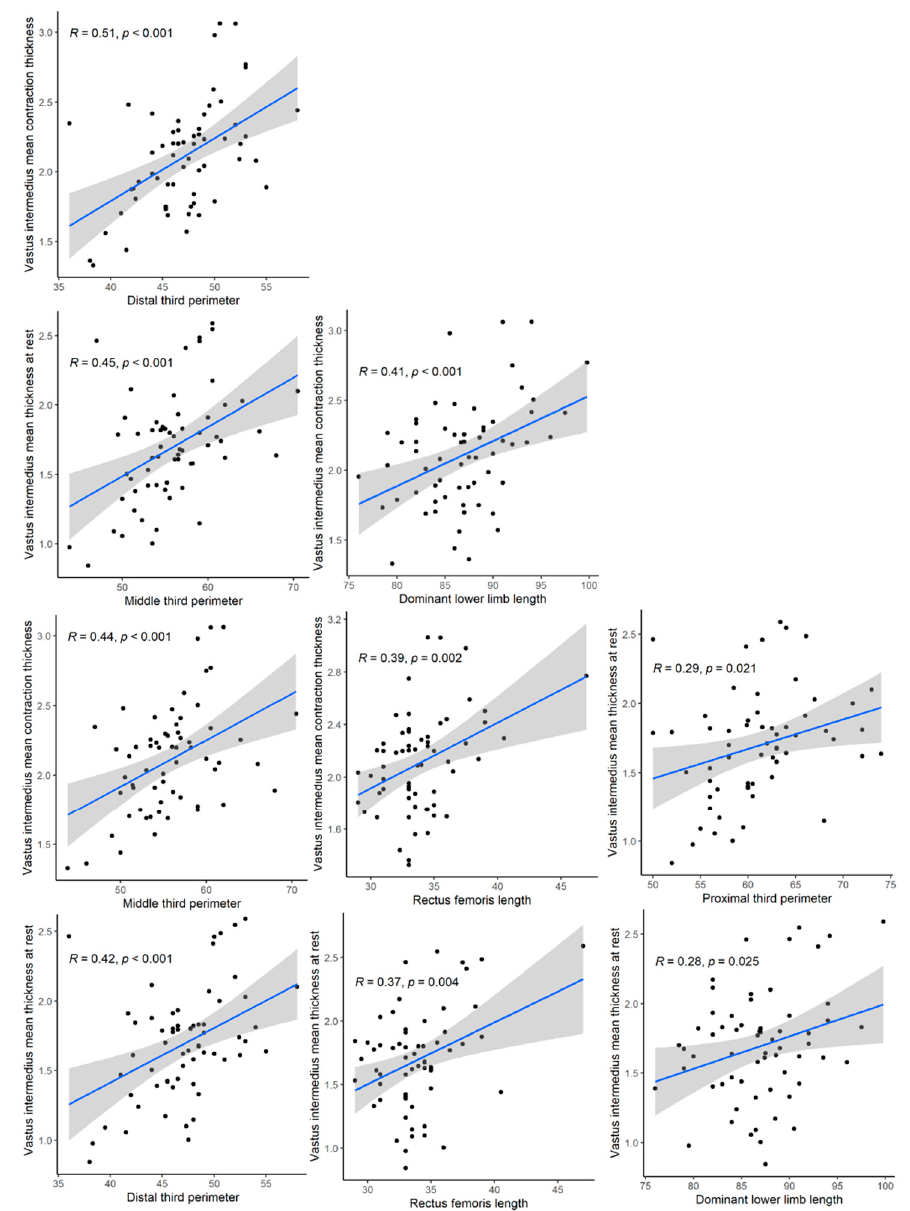
Figure 4. Significant correlations ( p < 0.05). Table 4. Baseline outcomes vs. thickness measurements correlations.